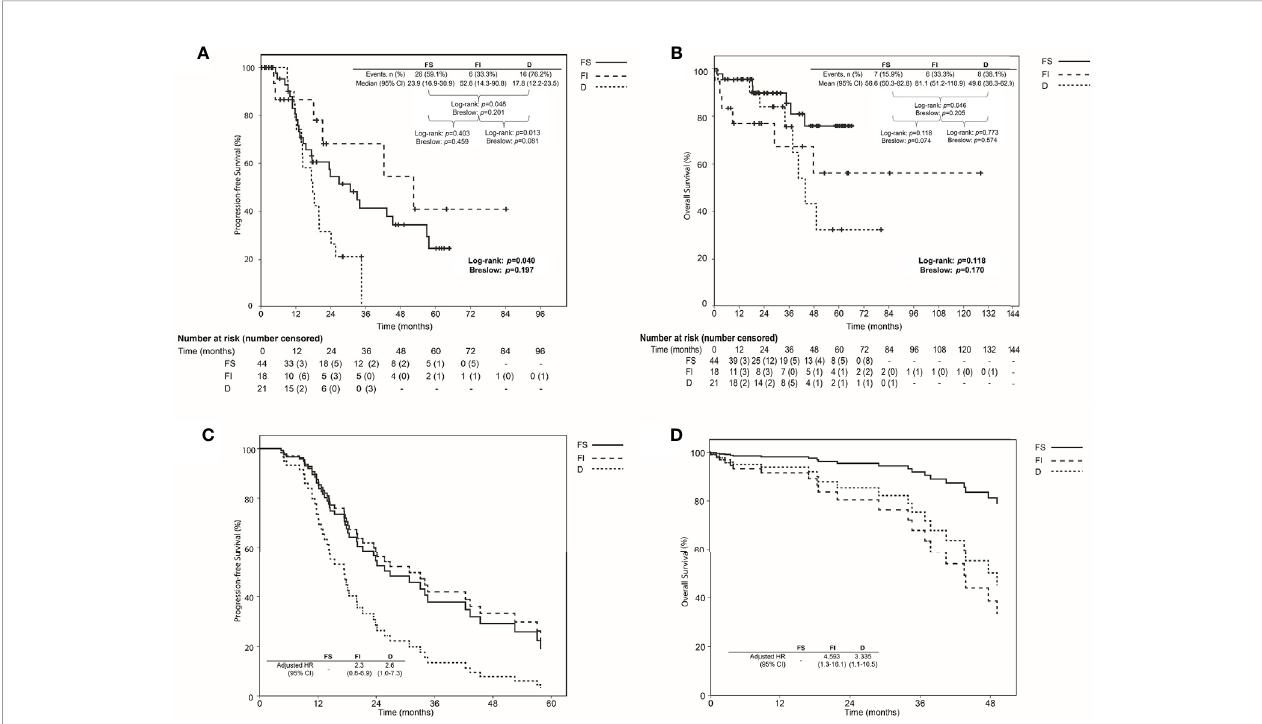
FIGURE 3 | Comparison of survival using Kaplan-Meier method with log-rank and Breslow tests among the focal and separable (FS), focal and inseparable (FI), and diffuse groups (D) based on the resection types of tumor involving the rectosigmoid colon: (A) Progression-free survival; (B) Overall survival; Comparison of the survival proportion by Cox proportional hazards regression analysis among the focal and separable (FS), focal and inseparable (FI), and diffuse groups (D) based on the resection types of tumor involving the rectosigmoid colon: (C) Progression-free survival; (D) Overall